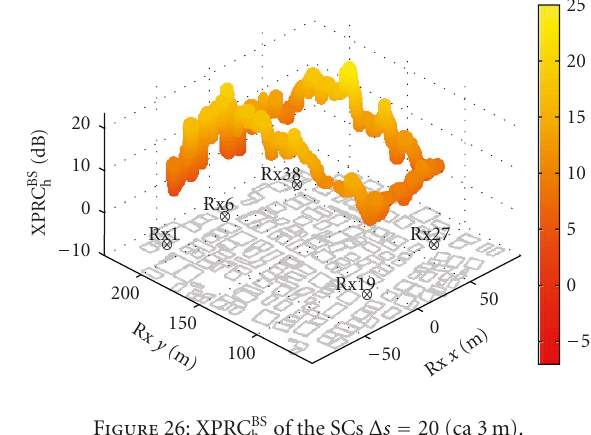
Figure 23: XPRC MS